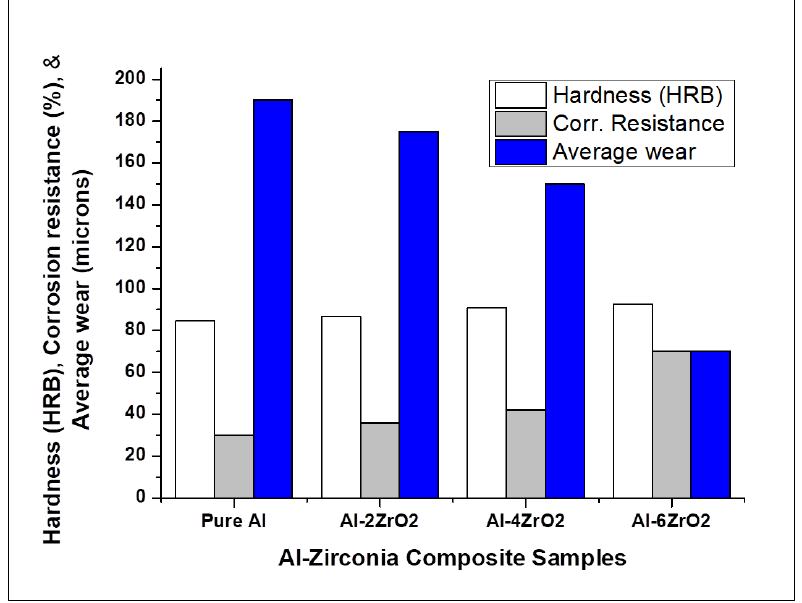
Figure 4. Property improvements of zirconia dispersion on Al matrix, adapted from [70].